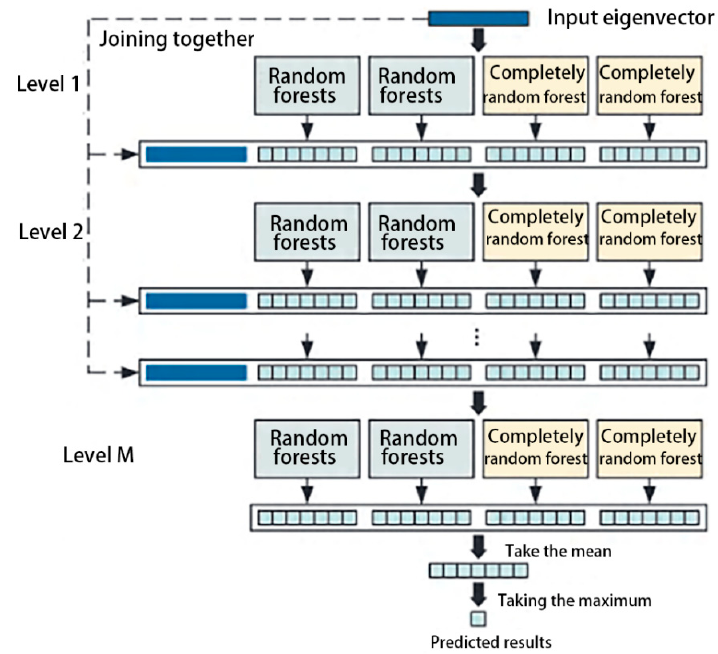
Figure 5. Cascade forest structure. The downward black arrow indicates the direction of data flow; the arrows pointing to the right indicate outputs belonging to forest models at a particular level; the dark blue bars represent data sets; the light blue squares represent outputs.